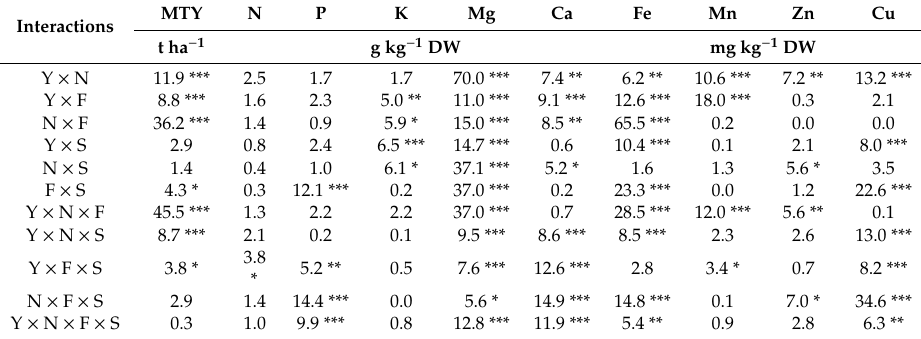
Table A1. Analysis of variance for interactions of factors in potato leaves.